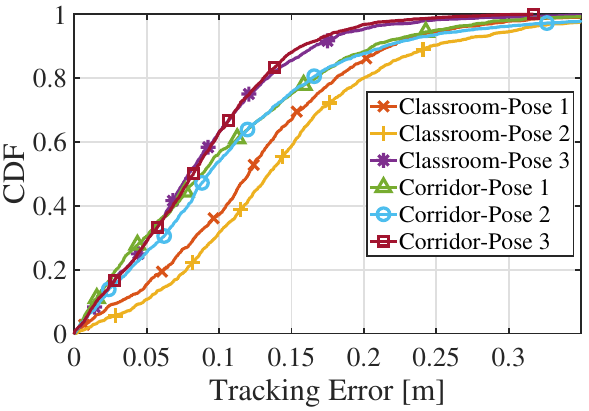
Figure 14. Tracking error CDF of Li-APF algorithm in each